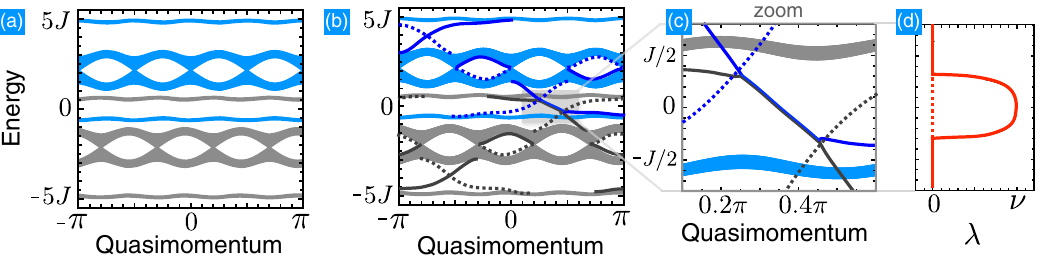
FIG. 5. Bogoliubov – de Gennes band structures. (a) BdG band structure for a system without boundaries. Here and in (b) and (c), the particle (hole) bands are plotted in blue (gray). The stability of the bulk is protected by the complete band gaps separating neighboring particle and hole bands. (b),(c) BdG band structure of a finite strip of width M ¼ 40 magnetic unit cells. The upper- (lower-)edge states are represented as thick solid (dashed) lines. (d) Corresponding amplification amplitudes λ . The parameters are the same as for Fig. 2 n 2 . 2 , ν ¼ 0 . 08 J ( ω 0 ¼ 2 . 15 J , Φ ¼ π = 2 , k p ¼